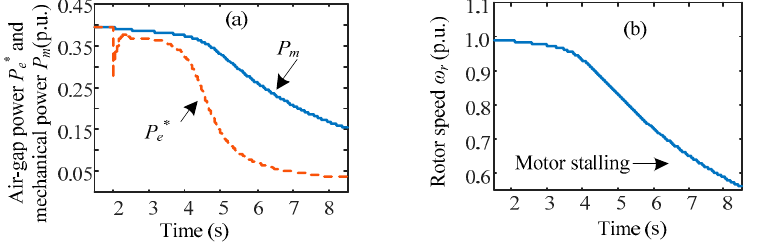
Figure 8. Dynamic response of IM loads ( a ) mechanical power P m and air-gap power P e *; ( b ) rotor speed ω r .